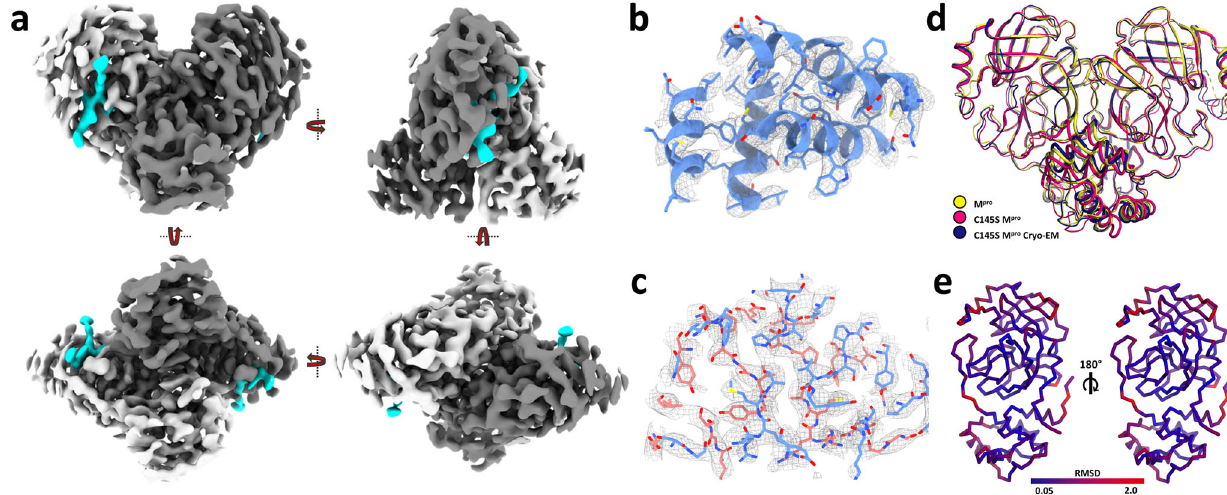
Fig. 3 | A. Overview of SARS-CoV-2 C145S M pro cryo-EM model. a Four-sides rotation view of fi nal map displayed as surface, with chains A and B coloured in whiteand grey,respectively,andactivesitepeptidemapcoloured incyan. b Chain A (blue) domain III model fi tted into fi nal map (grey). c Chain A (blue) and B (salmon) interface region fi tted into fi nal cryo-EM map (grey). d Superposition of